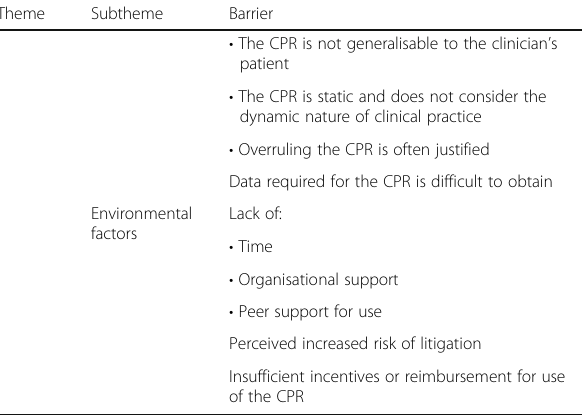
Table 4 Barriers to the use of clinical prediction rules in practice identified in the literature